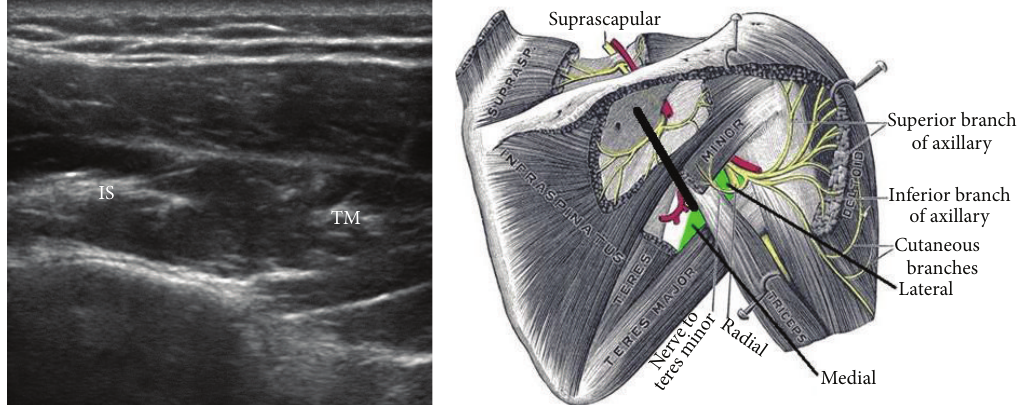
Figure 2: Short axis view of the myotendinous junction of the infraspinatus (IS) and teres minor (TM). Figure adapted from the medical gallery of Mikael